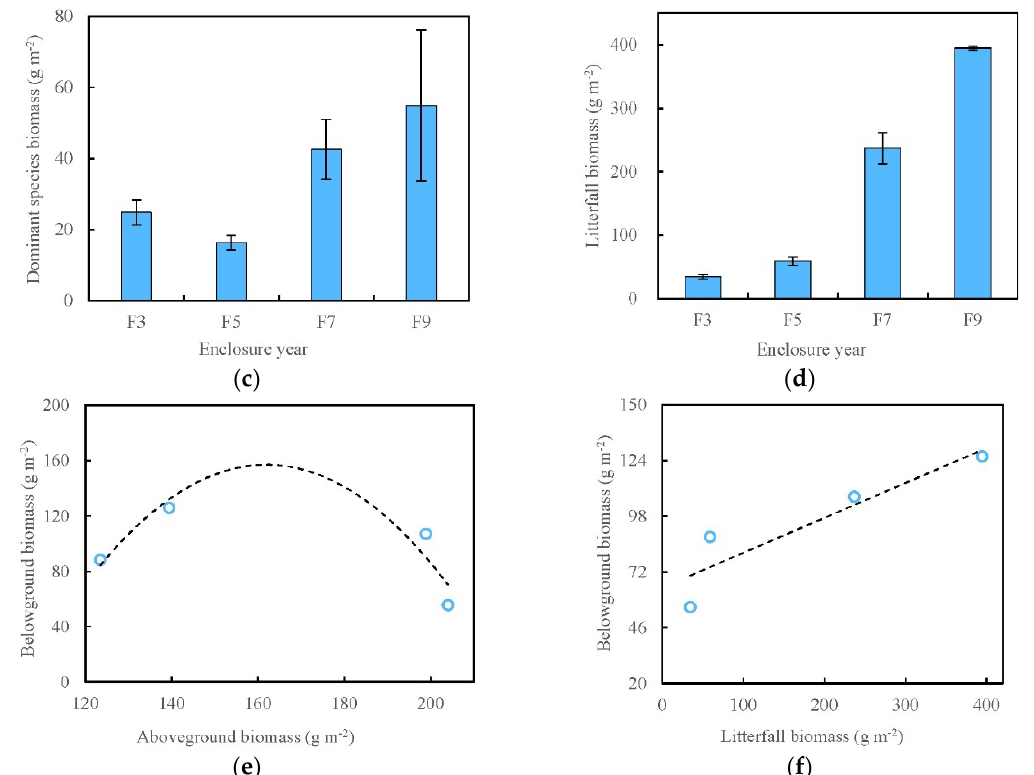
Figure 5. Temporal variations in plant biomass and relationships between biomasses measured above and below the soil surface. Aboveground biomass ( a ) and belowground biomass ( b ) were measured both inside and outside the enclosure, but the aboveground biomass of the dominant species ( c ) and the litterfall biomass ( d ) were only measured inside the enclosure. ( e ) Quadratic relationship between aboveground biomass and belowground biomass: y = − 0.05x 2 + 15.91x − 1131.50 ( R 2 = 0.79, p = 0.001) and ( f ) linear relationship between litterfall biomass and belowground biomass: y = 0.12x + 116.65 ( R 2 = 0.90, p = 0.001).